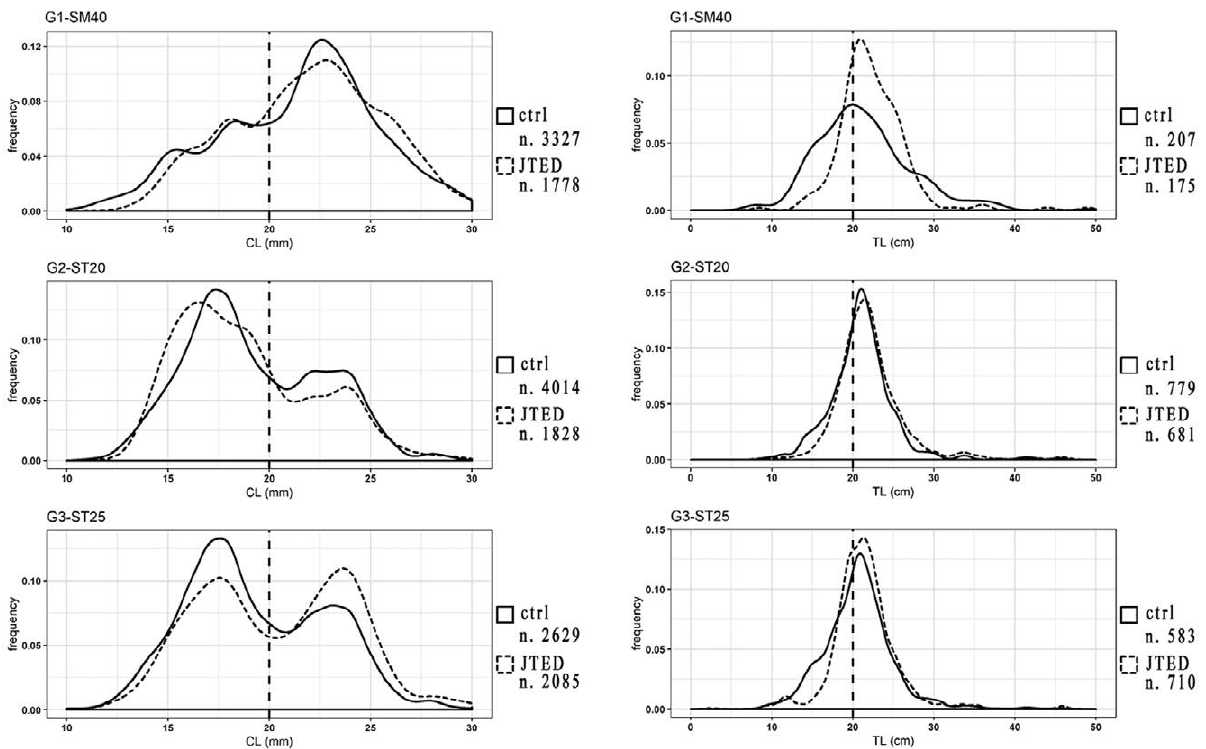
Fig. 3. – Comparison of the length frequency distributions of deep-water rose shrimp (DPS; left) and European hake (HKE; right), retained in the cod-end during the hauls with JTEDs (dashed line) and without grids (control [ctrl], solid